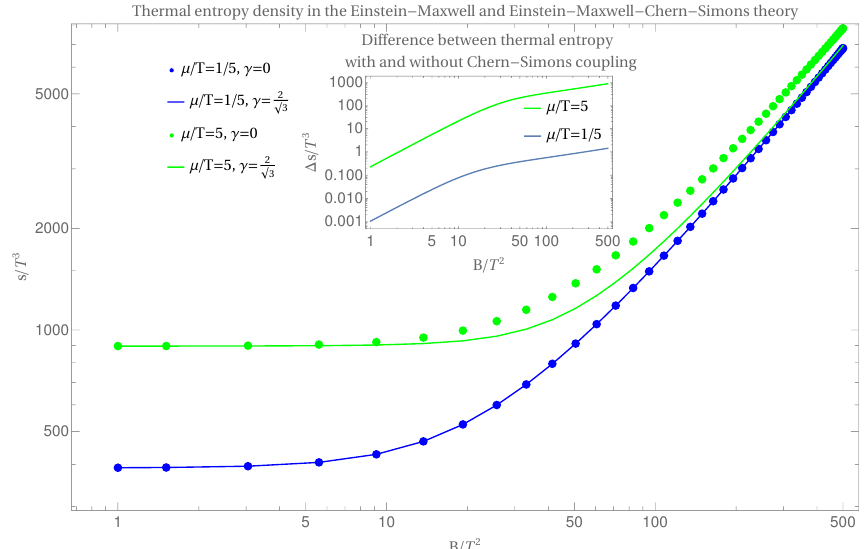
Figure 6 . We display the thermal entropy density including the chiral anomaly (solid lines, γ = √ γ SUSY = 2 / 3 ) as calculated from the black brane solutions within Einstein-Maxwell-Chern-Simons theory. This is compared to the case excluding the chiral anomaly (dotted lines, γ = 0 ) from black brane solutions in Einstein-Maxwell theory. A significant difference between the cases with and without anomaly is visible at the larger of the two displayed chemical potential values, µ/T = 5 (green curves). In the large- B/T 2 regime, s/T 3 scales approximately linearly with B/T 2 . The inset shows the difference, ∆ s , between the thermal entropy with ( γ = γ SUSY ) and without ( γ = 0 ) the chiral anomaly taken into account, i.e. it visualizes the contribution of the chiral anomaly to the thermal entropy. For later comparison, we keep in mind that this quantity is not peaked at any value of B/T 2